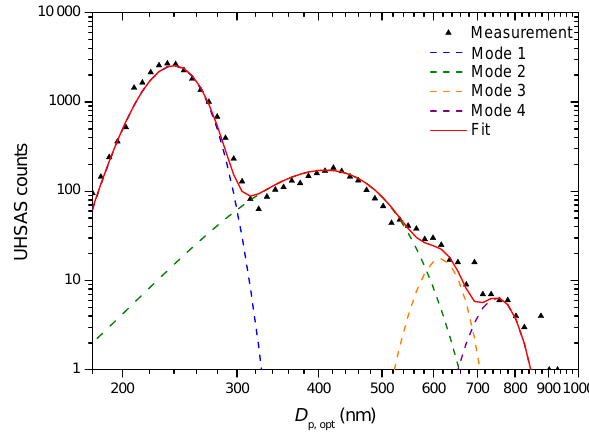
Figure 1. UHSAS measurements of dry dispersed brown coal fly ash particles after size selection of 300nm particles with a DMA. Shown is a mean over the first 30min of dry particle generation. The red line represents the least squares fit of a four-modal normal distribution to the measurement. The integrals over each of the four modes represent the number of singly, doubly, triply, and quadru- ply charged particles. Here, the multiple charge fractions were de- termined to 79.8% singly, 18.9% doubly, 0.9% triply, and 0.4% quadruply charged particles.